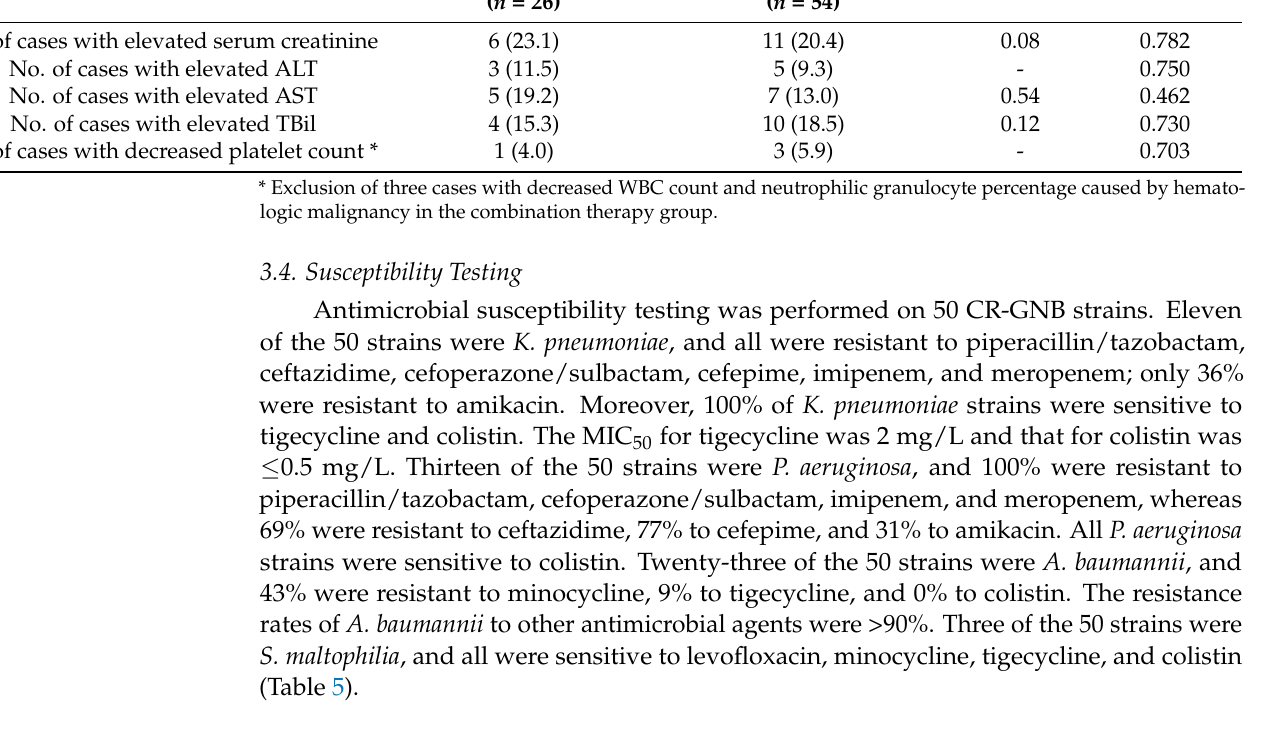
Table 5. The in vitro antimicrobial susceptibility of carbapenem-resistant Gram-negative bacteria. Acinetobacter